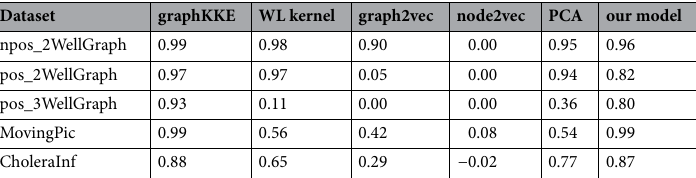
Table 2. Adjusted Rand Index (ARI) for the comparative analysis on the graph clustering task. ARI close to 1 corresponds to greater accuracy in correctly identifying the ground truth states, and an ARI value close to 0 stands for random